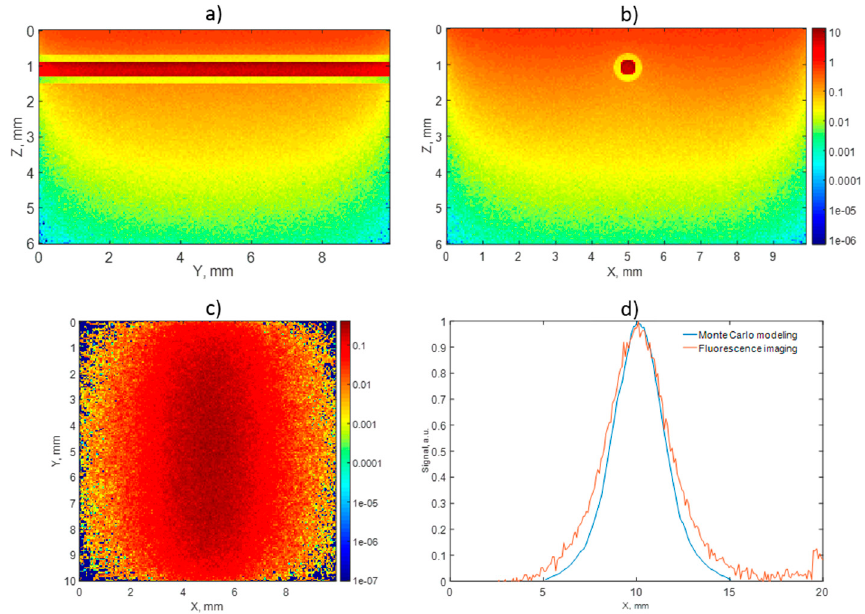
Figure 7. Monte Carlo simulations: absorption maps within the agar mixture phantom with embedded BPD tube at the wavelength of 690 nm in two projections ( a , b ), corresponding fluorescence image ( c ), and comparison of experimental and simulated fluorescence profiles ( d ). All maps are normalized for the number of launched photons per unit area. The absorption values in ( a , b ) are shown in mm − 1 , fluorescence intensity is dimensionless ( c ). Color map values in ( a – c ) are shown in logarithmic scale.